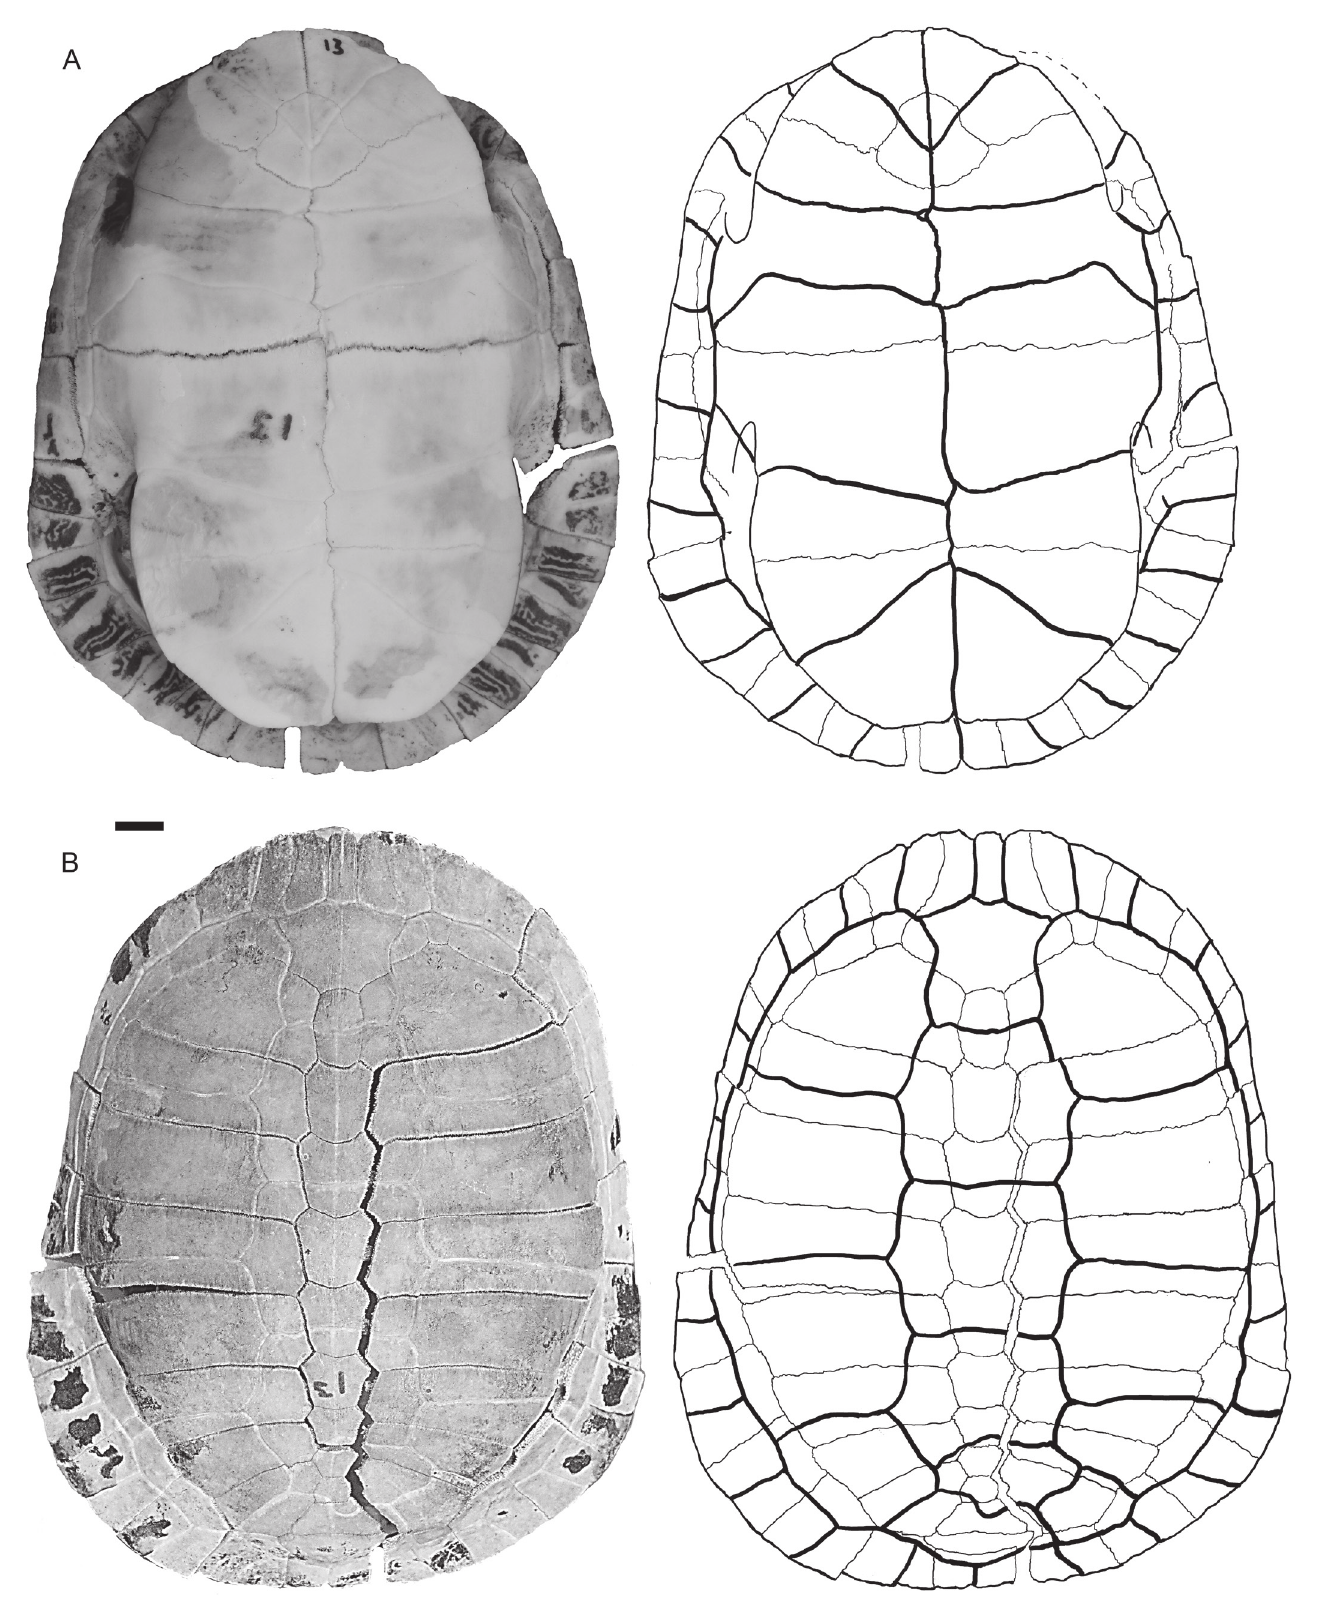
Figure 5. Chrysemys picta bellii, Neb 13. A, plastron and B, carapace. Scale bar = 1